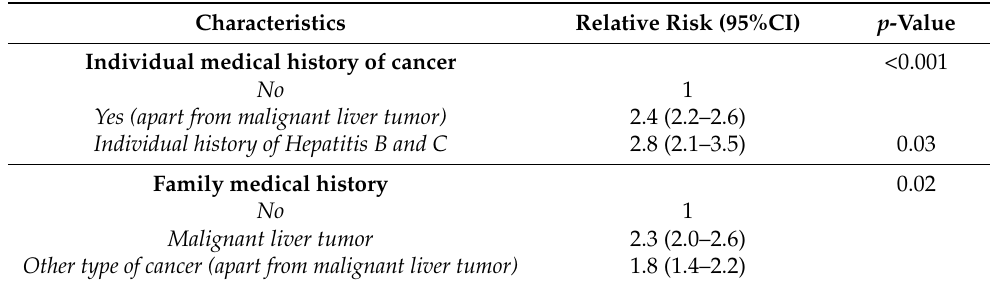
Table 2. Relative risk of low survival of patients with malignant liver tumor and association with risk